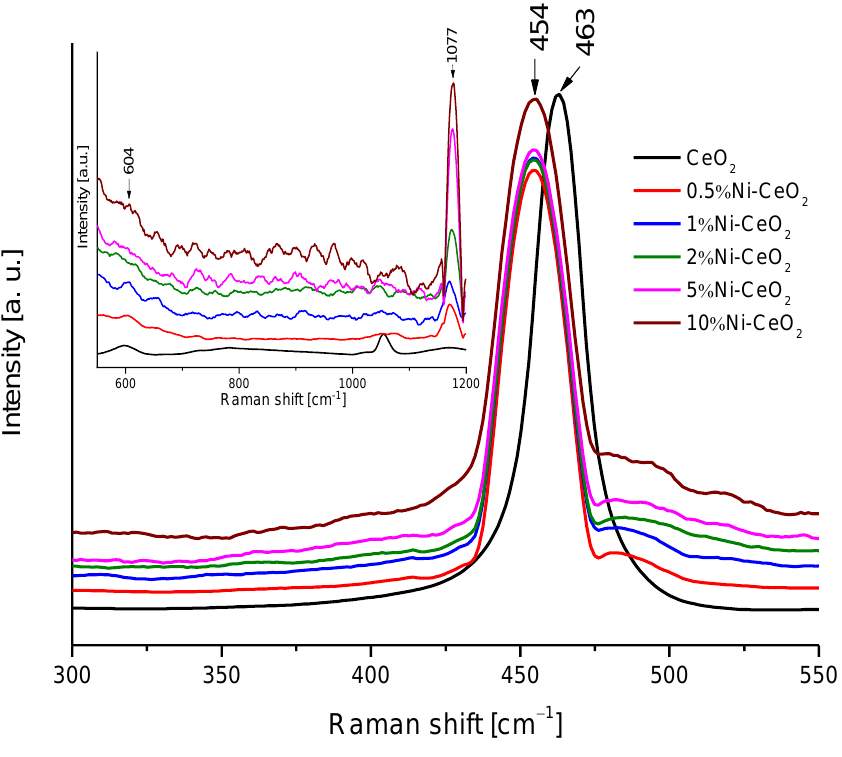
Figure 11. Raman spectra of the Ni-CeO 2 rods catalysts.